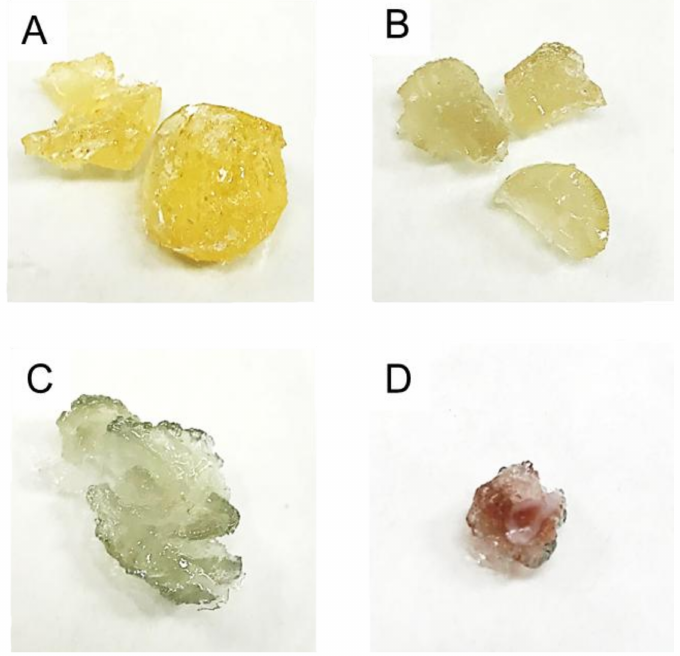
Figure 7. Resultant dried products received after applying routes for synthesis of ( A ) raw VBTAC- co -MBA copolymer as well as the samples ( B ) NC1; ( C ) NC2; and ( D ) NC3,